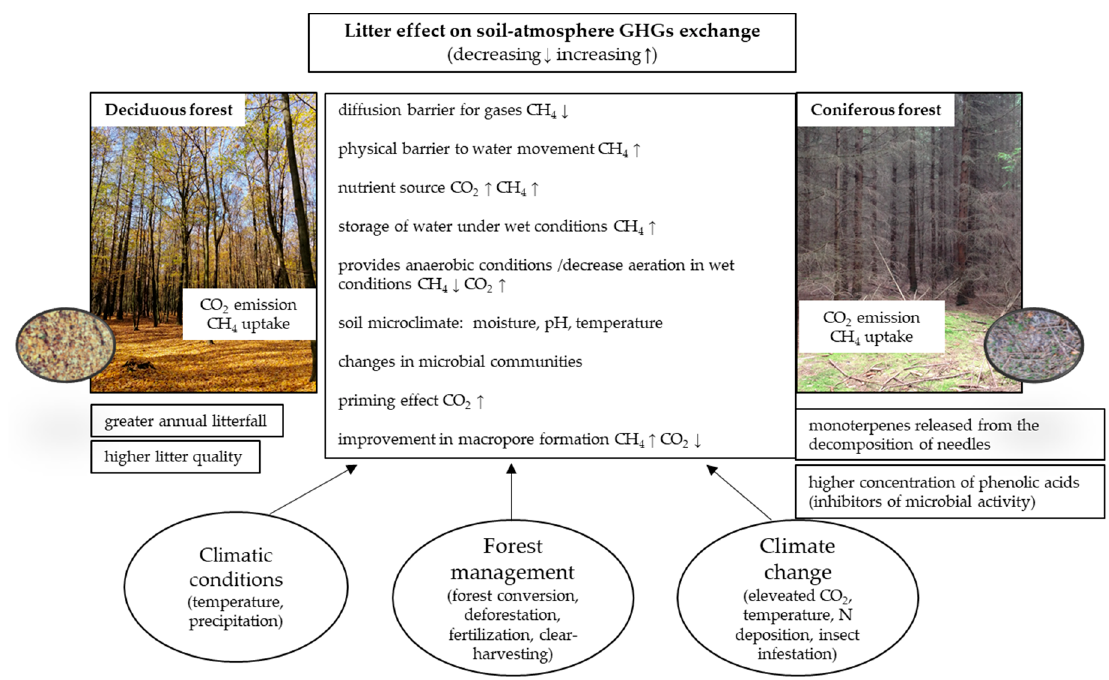
Figure 1. Diagram showing general drivers of litter effects on CO 2 emissions and CH 4 uptake, including regulating factors.